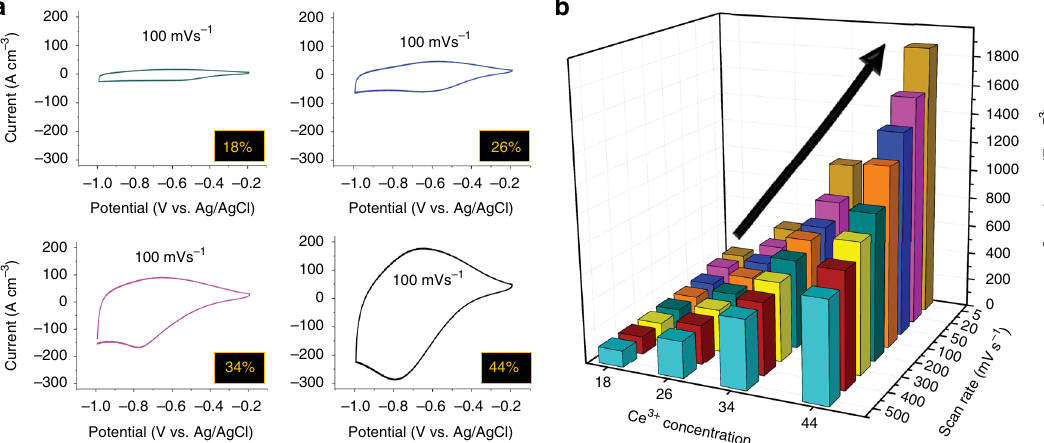
Fig. 6 Effect of scan rate on Ce 3 + concentration and capacitance of thin fi lms. a Pseudocapacitance-related cyclic voltammograms of CeO 2 − x deposited at scan rates of 50 mV s -1 (green), 300 mV s -1 (blue), 1000 mV s -1 (purple) and 3000 mV s -1 (black) (percentage in box is [Ce 3 + ]). b Three-dimensional plot showing volumetric capacitances at scan rates of 5 – 500 mV s -1 for thin fi lms with [Ce 3 + ] of 18, 26, 34 and